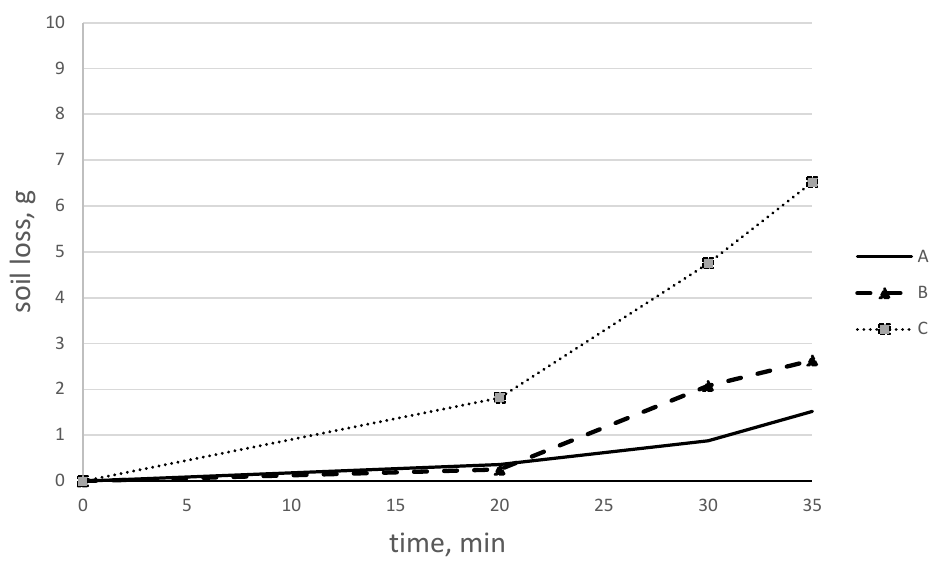
Figure 10. Weight of soil sediments sampled during the simulated rain in the three locations: (A) no traffic; (B) single pass; (C) multiple passes/permanent tramlines.